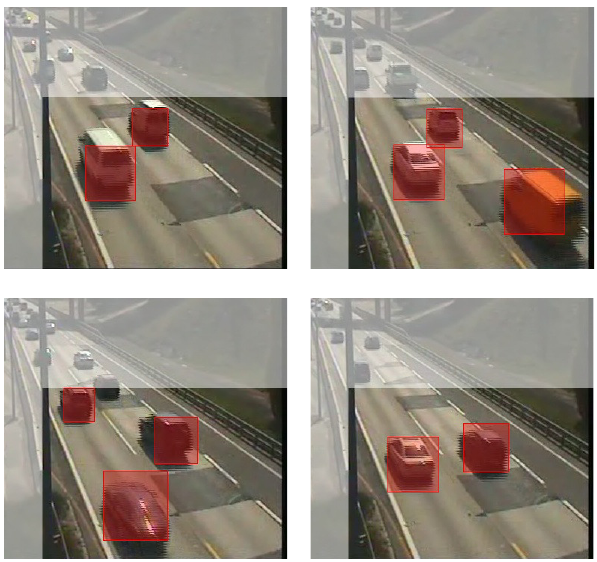
Figure 12. illustrative detection results of the generic car detector for the Highway